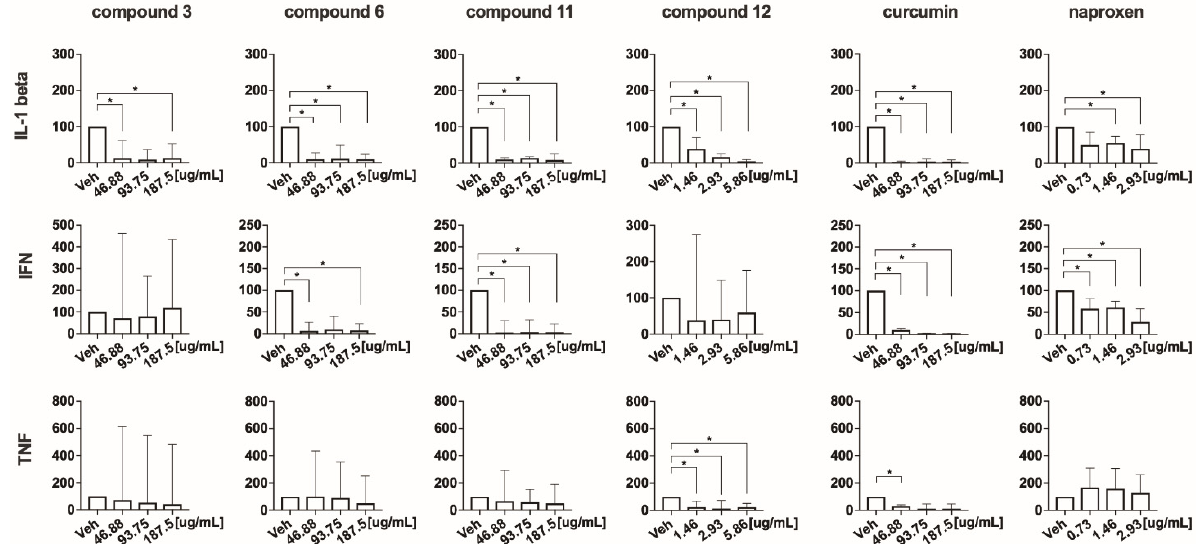
Figure 6. Summary of IL- 1 β , IFN- γ , and TNF- α analyzes in cell culture supernatants from PBMC stimulation with PMA-IO in the presence or absence of the monocarbonyl analogs of CUR. PBMCs were stimulated with PMA-IO for 24 h in the presence or absence (veh) of selected compounds ( 3 , 6 , 11 , 12 , CUR, and naproxen). The levels of Il- 1 β , IFN- γ , and TNF- α , were measured in cell culture supernatants using commercially available ELISA sets. The results are presented as a percentage of LPS stimulated control (veh) n = 5; a Wilcoxon test was used, * p < 0.05.